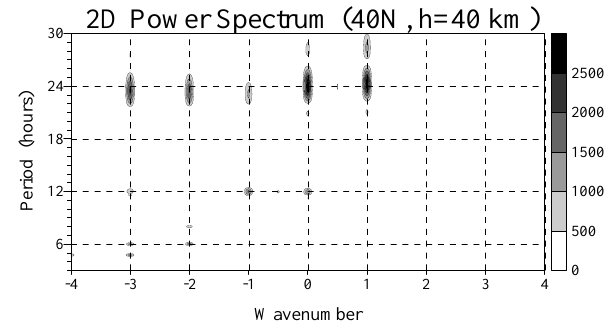
Figure 3 Fig. 3. Two-dimensional power spectrum obtained by a Fourier transform of the two-dimensional autocorrelation function; the spectrum is calculated for the period range 3–30h and zonal wave numbers between − 4 and 4 from the SABER data for latitude 40 ◦ N and altitude 40km and for the period of time